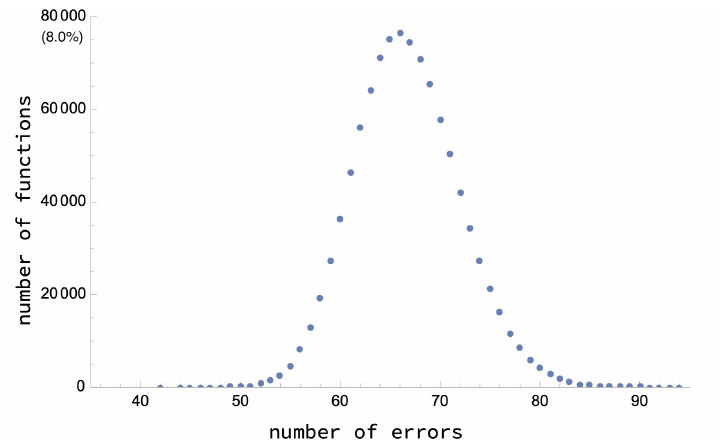
Figure 8. A tally count according to the number of errors to MAJ among the averaging approximators using one million random pairs of